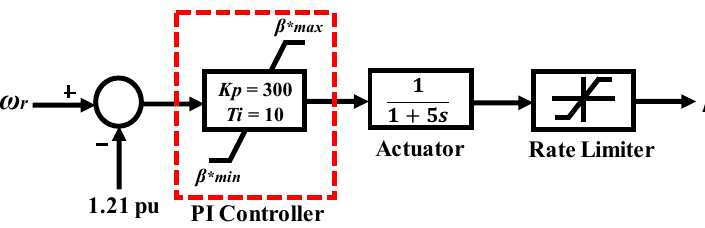
Figure 3. Pitch controller for variable ‐ speed wind turbine (VSWT).